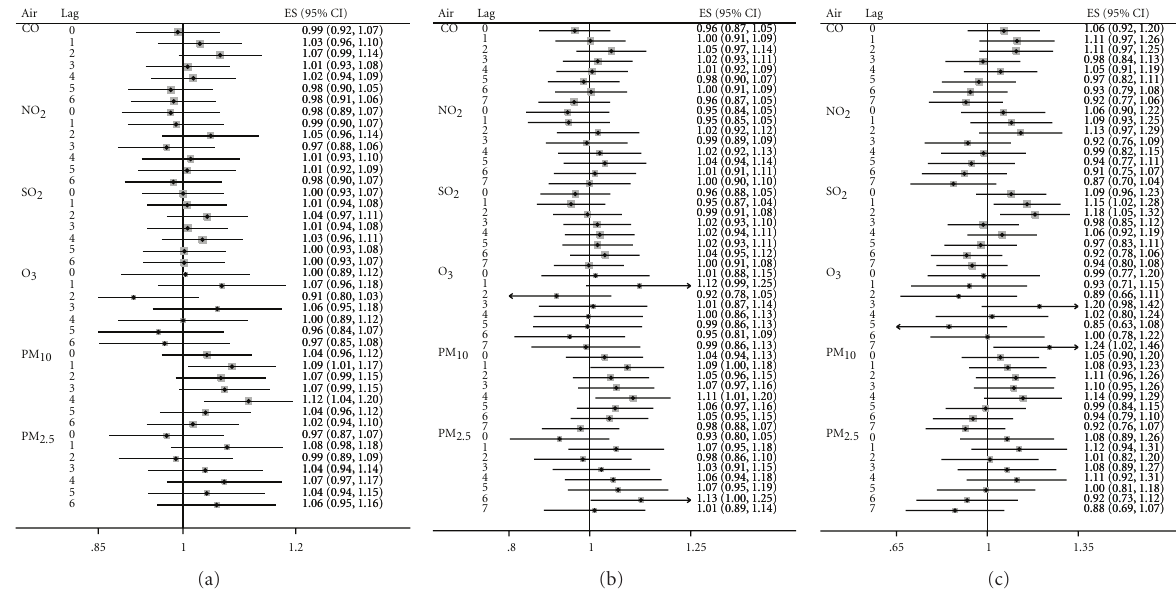
Figure 2: Odds ratios for ED visits for seizure associated with exposure to air pollutants.